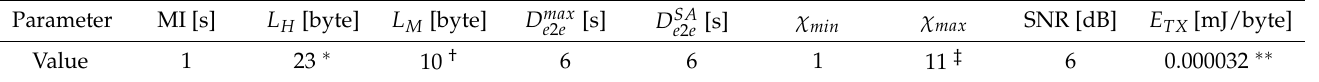
Table 3. Default parameter values for the WSN and optimal bundling.